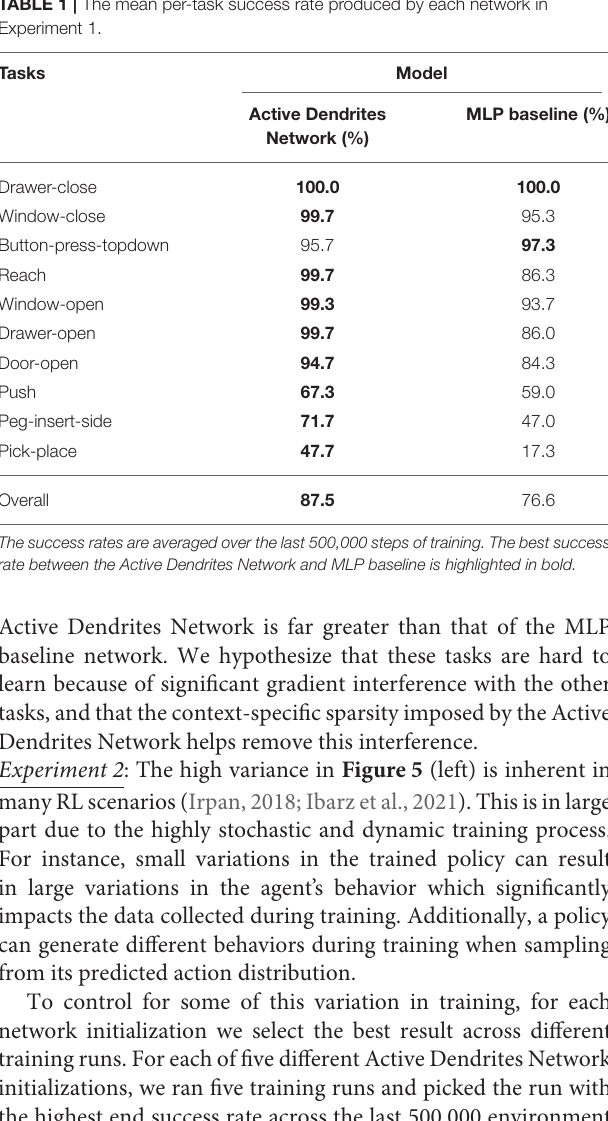
TABLE 1 | The mean per-task success rate produced by each network in Experiment 1. Tasks